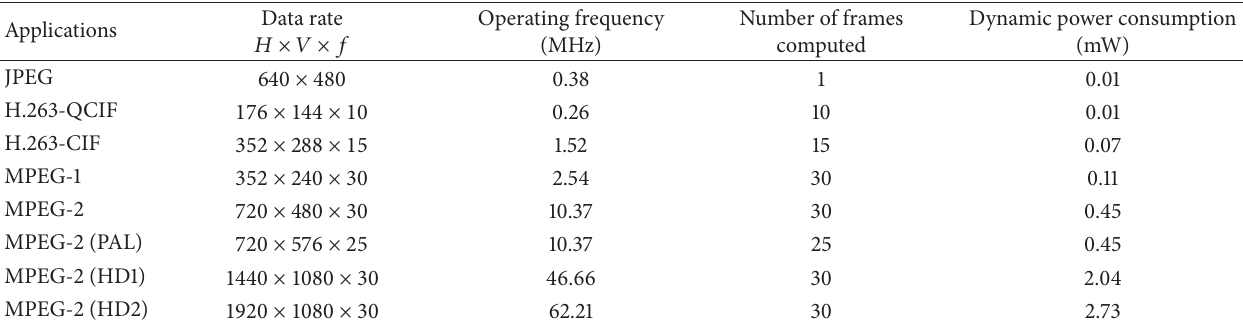
Table 10: Proposed design applications to various image/video standards ( 8 × 8 block